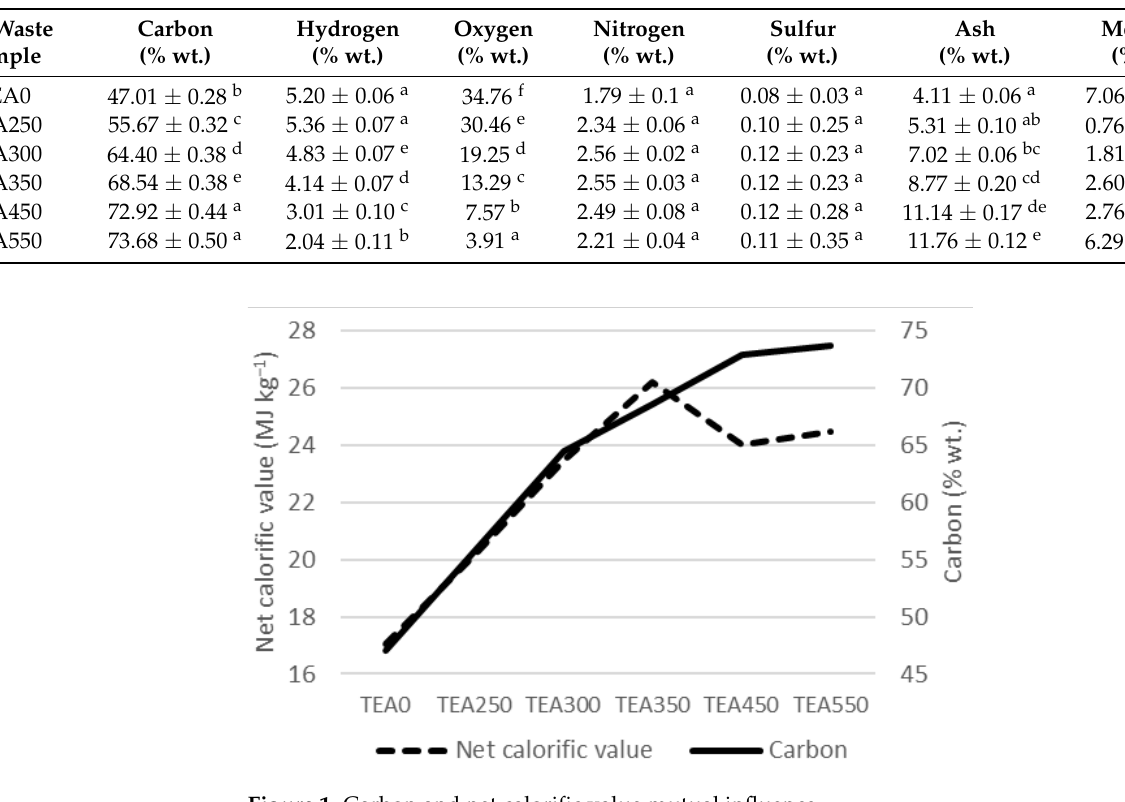
Table 3. Proximate and ultimate analysis for tea waste sample. Values are means ± SE ( n = 3). Dif- ferent letters (a –f) indicate significant differences based on Tukey’s test ( p < 0.05).